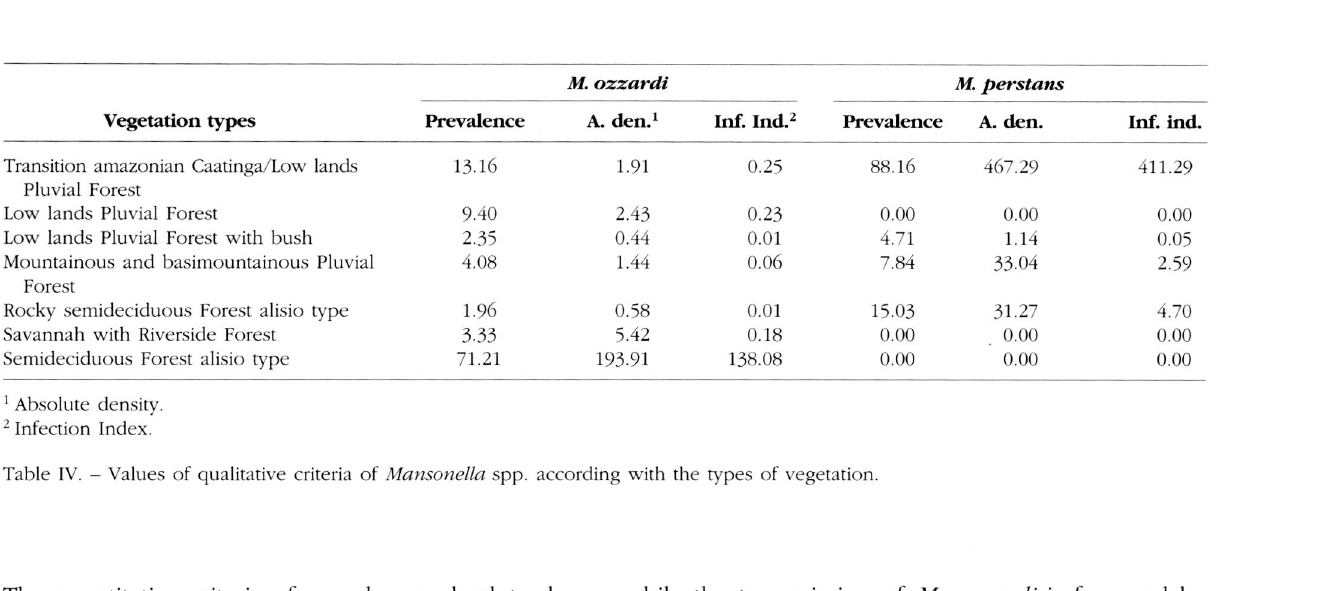
The quantitative criteria of prevalence, absolute den­ sity and infection index calculated for M. perstans